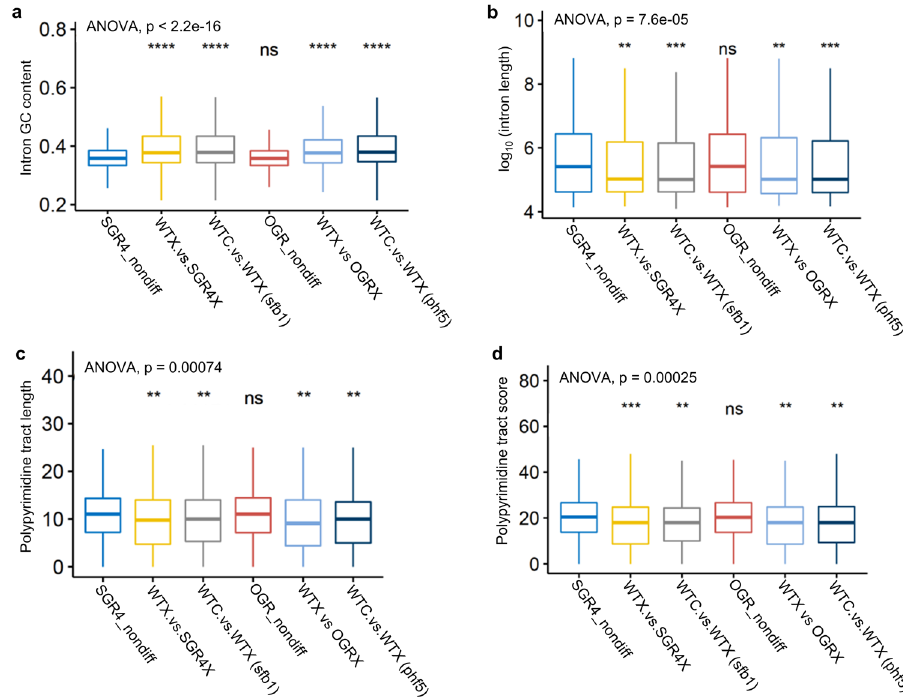
Fig. 6 SGR4 and OGR show speci fi city for splicing-related features. a Intron GC content, b Intron length, c Polypyrimidine tract length, and d Polypyrimidine tract score (as de fi ned by SVM-BP, http://regulatorygenomics.upf.edu/Software/SVM_BP/) of introns not affected by GEX1A in SGR4 (SGR4 nondiff) or OGR (PHF5A-Y36C heterologous expressor, OGR_nondiff), introns differentially retained in GEX1A-treated SGR4 or OGR as compared to their corresponding WT (WTX.vs.SGR4X and WTX vs OGRX, respectively) in the same condition, and introns affected by GEX1A in the WT of the SGR4 or OGR experiment (WTC.vs.WTX (sfb1) and WTC.vs.WTX (phf5), respectively). The polypyrimidine tract score indicates C/T content of the polypyrimidine tract between Branch Point and 3 ′ splice